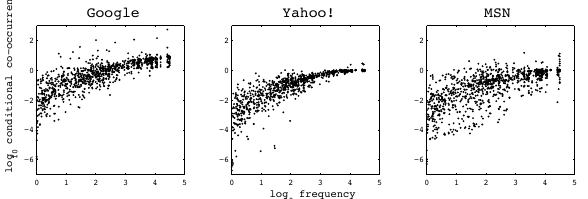
Figure 2. Conditional co-occurrence probability plotted against frequency for words in the Potsdam Sentence Corpus. There is a marked correlation between the two parameters, especially in the results produced by the Google and Yahoo! search engines. Note that some of the results show conditional co-occurrence probabilities greater than one (or equivalently, the logarithm greater than zero); this anomaly occurs because we directly use the frequency estimates produced by the search engines, which exhibit both noise and systematic